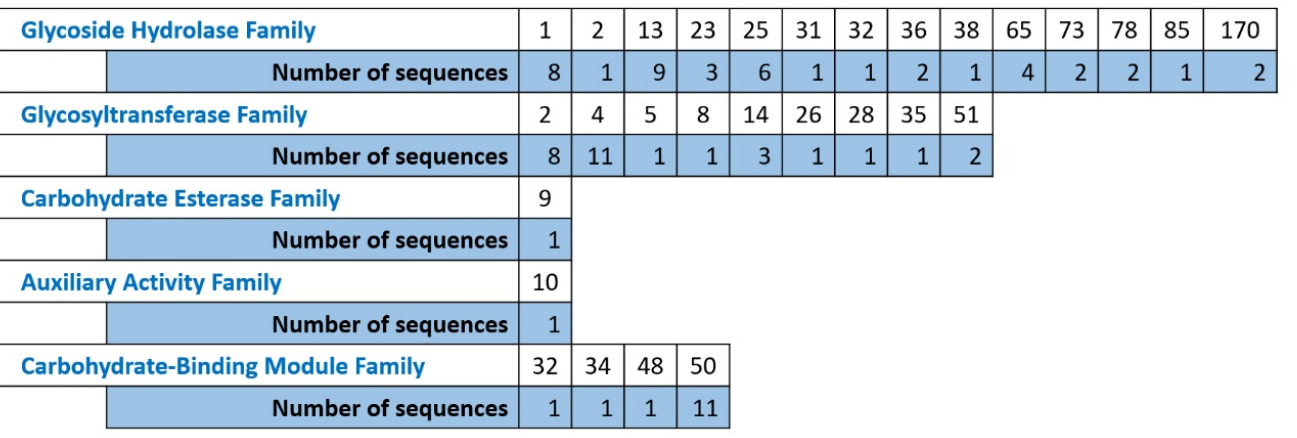
Figure 3. The prediction of the glycoside hydrolase family, glycosyltransferase family, carbohydrate esterase family, auxiliary esterase family, and carbohydrate-binding module family by the CAZy database.